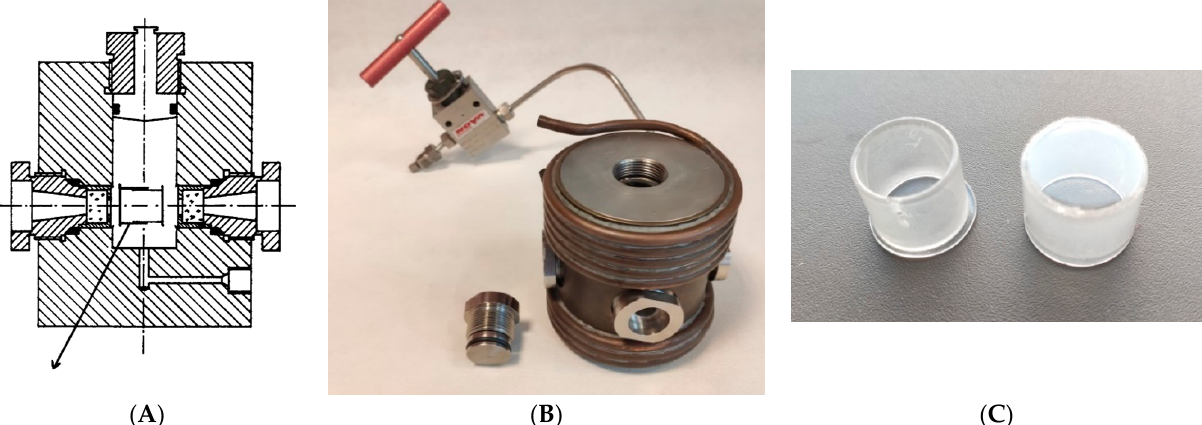
Figure 2. ( A ) Two-window optical high-pressure cell consisting of 1 cm–thick quartz windows and sealed by O- and ∆ -rings for pressures up to 200 MPa. Usually the pressure medium is water and is thermostated by an outer copper coil not shown in the diagram. The pill-box consists of two closely fitting quartz cylinders which allow compression of the solution inside the cell. There is a special hole drilled through both cylinders by which the pill-box optical cell can be filled and sealed by turning the two cylinders 180° apart. ( B ) Four-window optical high-pressure cell with a thermostating copper coil. ( C ) Two separated cylinders of the pill-box optical cell that make a gastight fit. Reproduced from Reference [18], with the permission of AIP Publishing.